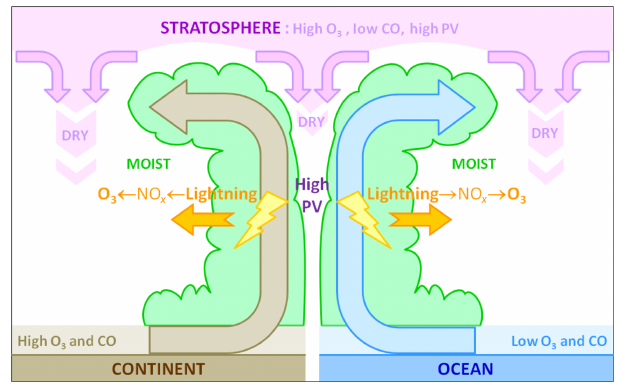
Figure 15. A schematic cross section (not to scale) of a model ty- phoon and associated transports of ozone and carbon monoxide in relation to dry and moist regions and high-potential-vorticity zones (see